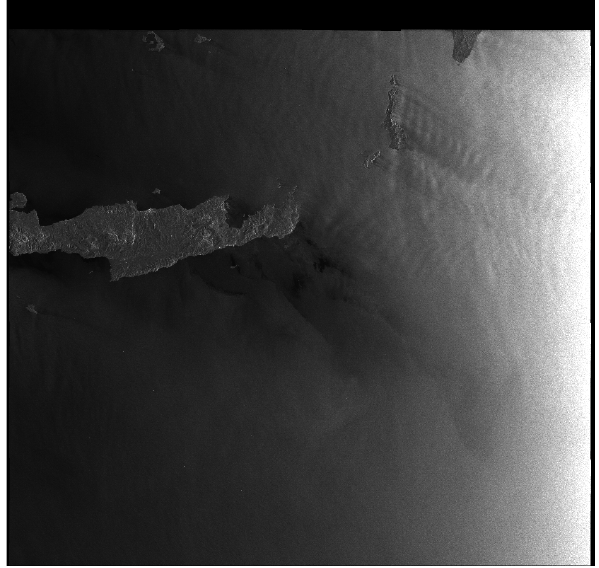
Figure 1. Detail of the Envisat ASAR Wide Swath image at 08:20UTC, 15 May 2008 in the vicinity of Crete. Pixel size is 75m by